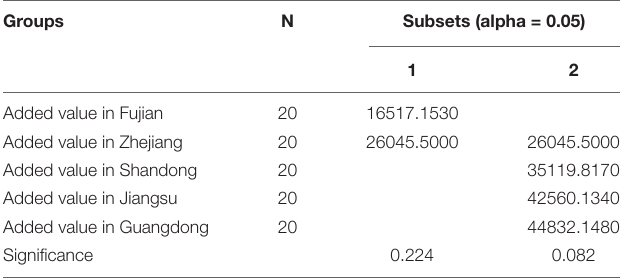
TABLE 4 | Results of the one-way ANOVA for industrial added value. Sum of squares